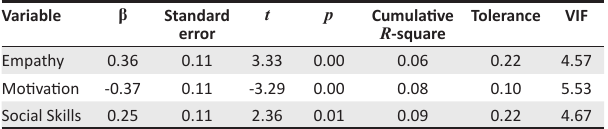
TABLE 5: Stepwise multiple regression.